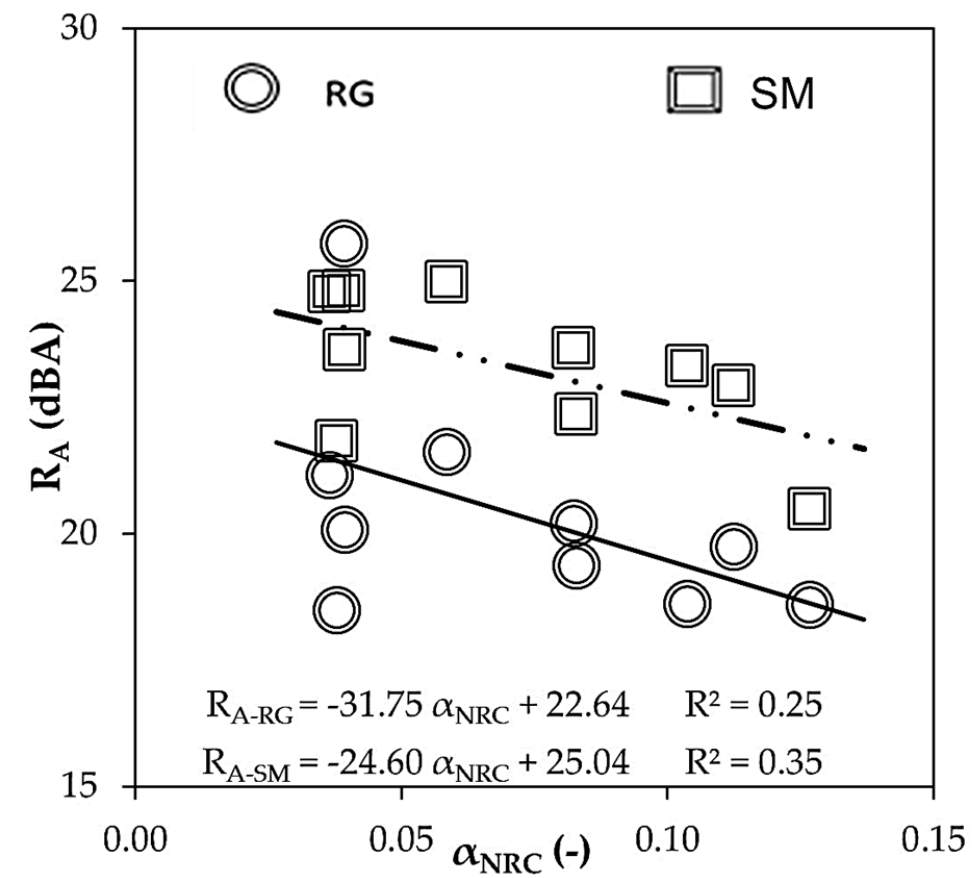
Figure 9. Experimental sound reduction index (R A ) on rough (RG) and smooth (SM) sides versus noise reduction coefficient ( α NRC